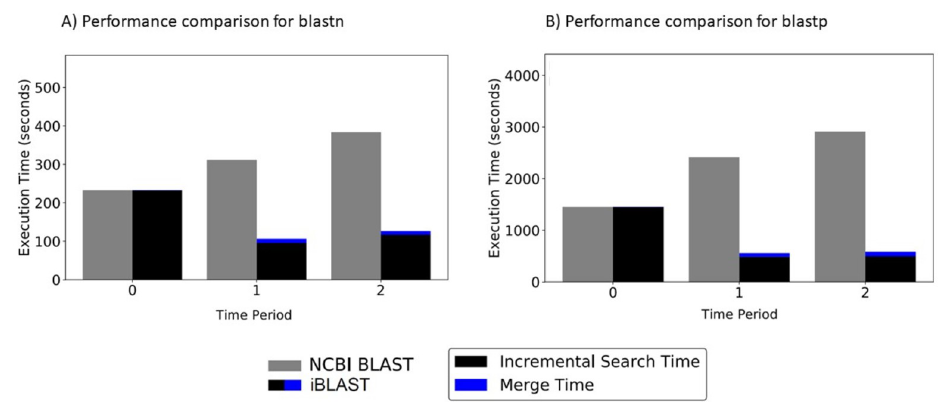
Fig 4. Performance comparison between NCBI BLAST and iBLAST for case study I. (A) Performance comparison between regular blastn and incremental blastn at 3 periods when nt database is growing over time, using 100 nucleotide queries. For 40.8% and 34.0% increase in the database size, iBLAST performs 2.93 and 3.03 times faster respectively. (B) Performance comparison between regular blastp and incremental blastp at 3 periods when nr database is growing over time, using 100 protein queries. For 34.1% and 26.3% increase in the database size, iBLAST performs 4.33 and 4.98 times faster respectively.